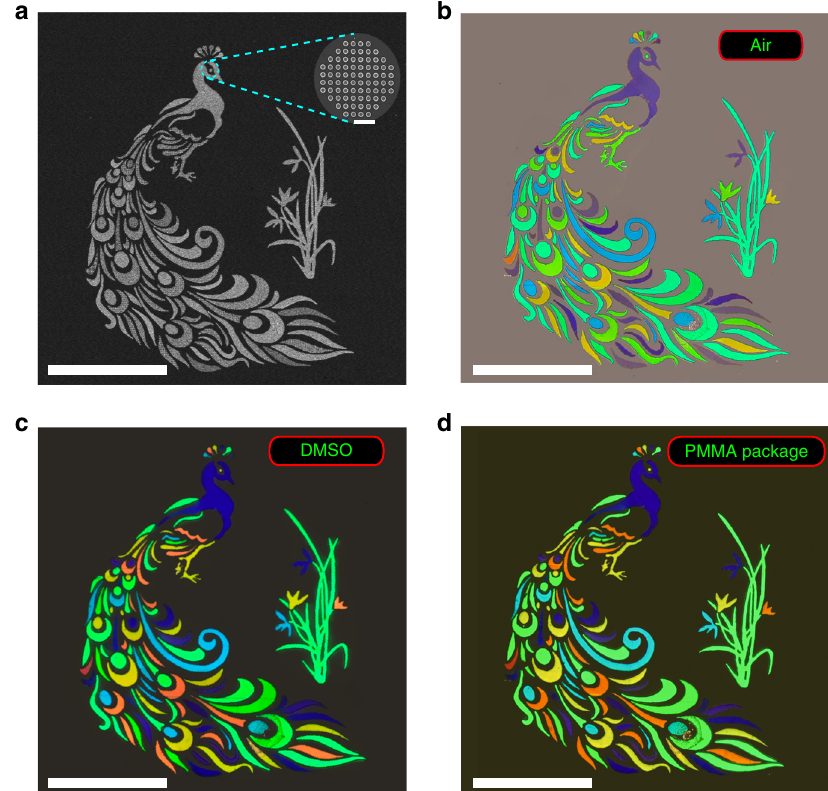
Fig. 5 Full-color image printing with Si metasurface. a The top-view SEM image of a peacock with an orchid. The scale bar is 100 µ m. Panels b – d are the corresponding bright- fi eld microscope images in air, DMSO solution and packaged with PMMA. The scale bar is 100 µ m, and the scale bar of inset SEM is 1 µ